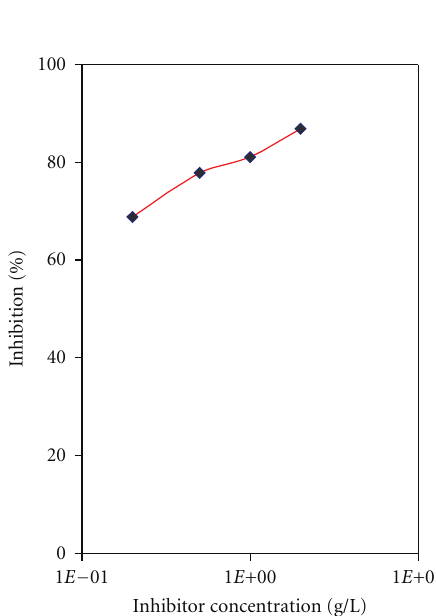
Figure 4: Percentage inhibition of di ff erent concentrations of the aqueous extract of Neem leaves on carbon steel surface in 1.0 M HCl solution at room temperature based on anodic and cathodic polarization